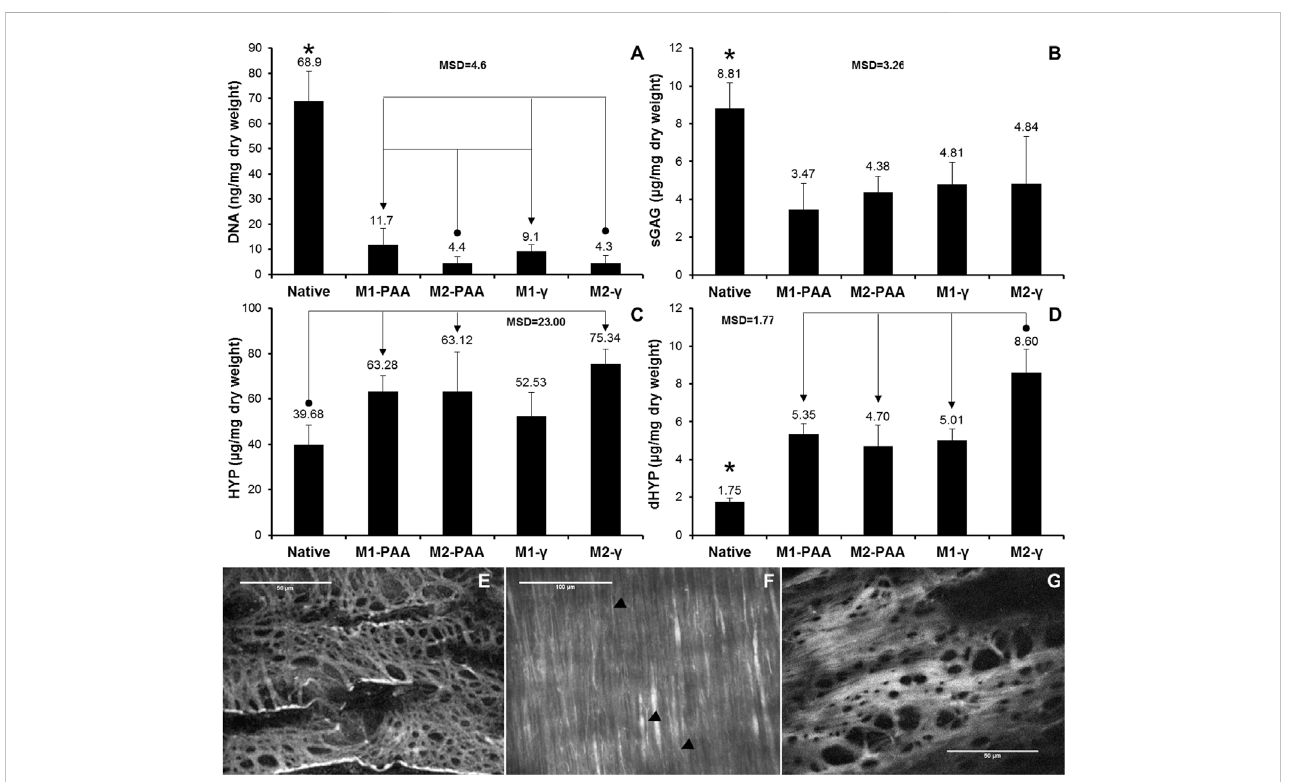
FIGURE 4 Mean DNA (A) , sGAG (B) , HYP (C) and dHYP (D) content per dry weight of native PTA and decellularized PTA scaffolds treated with (M2) or without (M1) RNase/DNase and sterilized with either PAA or γ -irradiation. Data was expressed as means ( n = 6); error bars indicate 95% C.I.; MSD: minimum signi fi cant difference; indicates signi fi cant difference between the native and the decellularized groups. Connectors indicate signi fi cant difference between the originatorandendarrowgroup. (E – G) Characteristic enface multiphotonimagesofthelumenofdecellularizedPTAs,treatedwithM1andsterilizedwith either PAA (E,F) or γ -irradiation (G) , showing the elastic fi ber network of internal elastic lamina (E, G; imaging plane was approximately 20 μ m below lumen surface)andthecollagen fi bersoftunicamedia(F;imagingplanewasabout60 μ mbelowlumensurface).Blackarrowheads( ► )showelastic fi bers.Scalebars indicate 100 μ m (E,F) or 50 μ m (G)